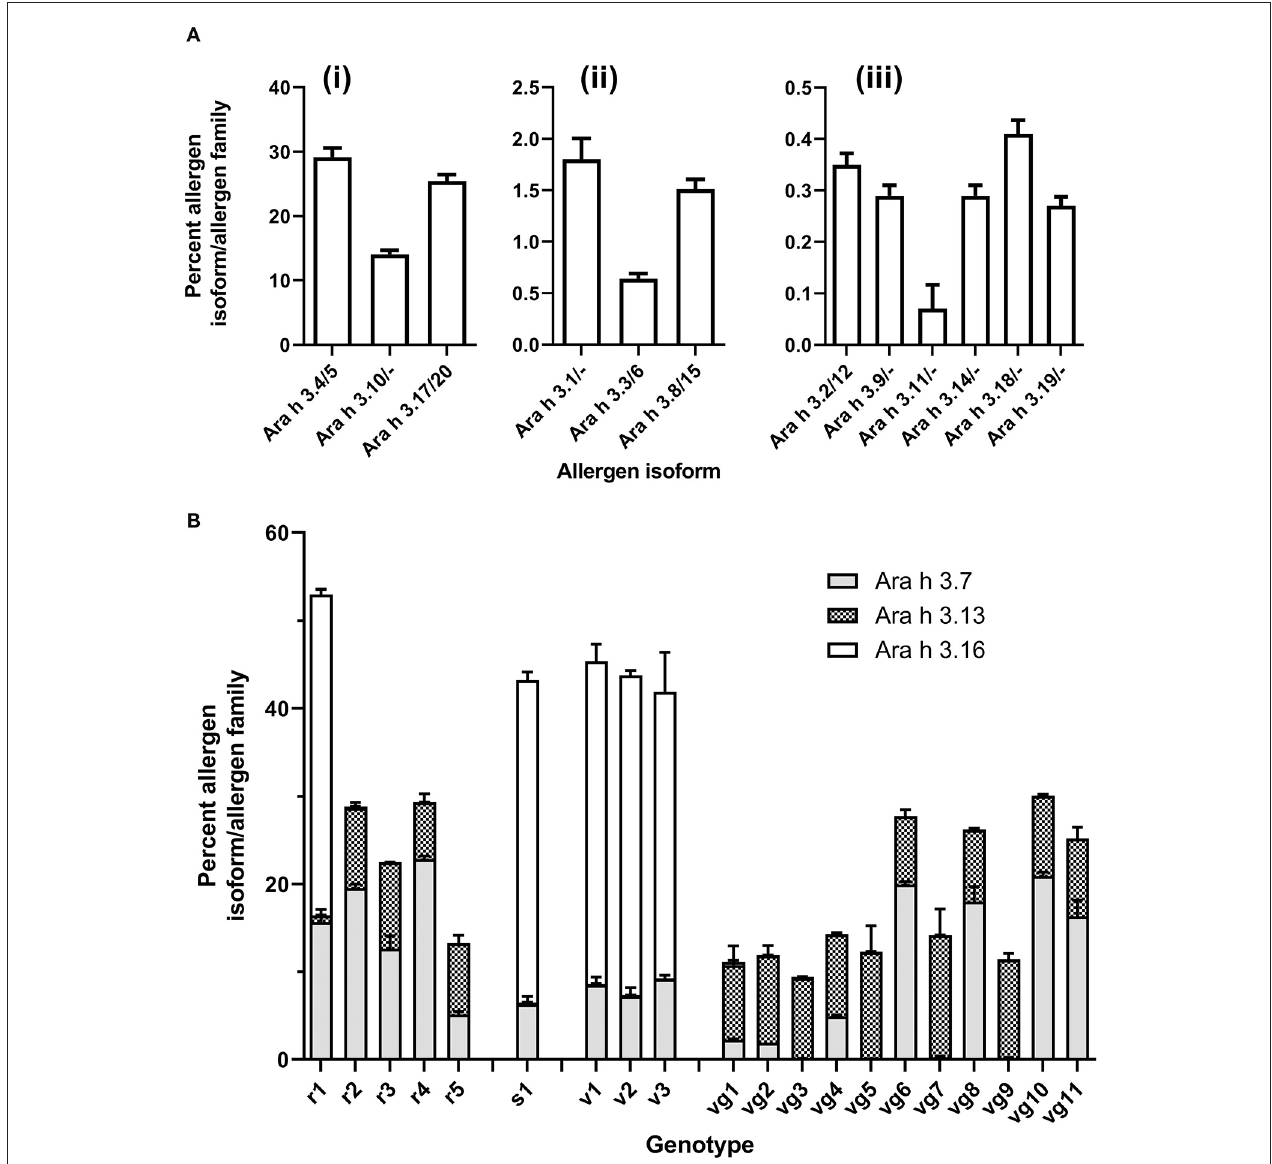
FIGURE 4 | Isoform distribution of Ara h 3 across genotypes as determined by specific isoform (unique) peptide quantitation. Allergens were quantified using unique peptides ( Supplementary Table S2 ) and normalized to glycogen phosphorylase. Stacked bar histogram plots show the mean protein content % [weight (allergen) /weight (total allergen)] in peanut for each allergen family and standard error of the mean (bar) from two biological replicates, which had two technical replicates for each sample (left y -axis). Each peanut genotype analyzed is shown on the x -axis. (A) , Ara h 3 isoforms, in all genotypes (i) high-abundance Ara h 3 isoforms ( > 2.5 % (w/w): Ara h 3.4/5, Ara h 3.10, and Ara h 3.17/20 (ii) mid-abundance Ara h 3 isoforms [2.5–0.5% (w/w)]: Ara h 3.1, Ara h 3.3/6, and Ara h 3.8/15 (iii) low-abundance Ara h 3 isoforms ( < 0.5 % (w/w)): Ara h 3.2/12, Ara h 3.9, Ara h 3.11, Ara h 3.14, Ara h 3.18, and Ara h 3.19. (B) , Variable Ara h 3 isoforms: Ara h 3.7, Ara h 3.13, and Ara h